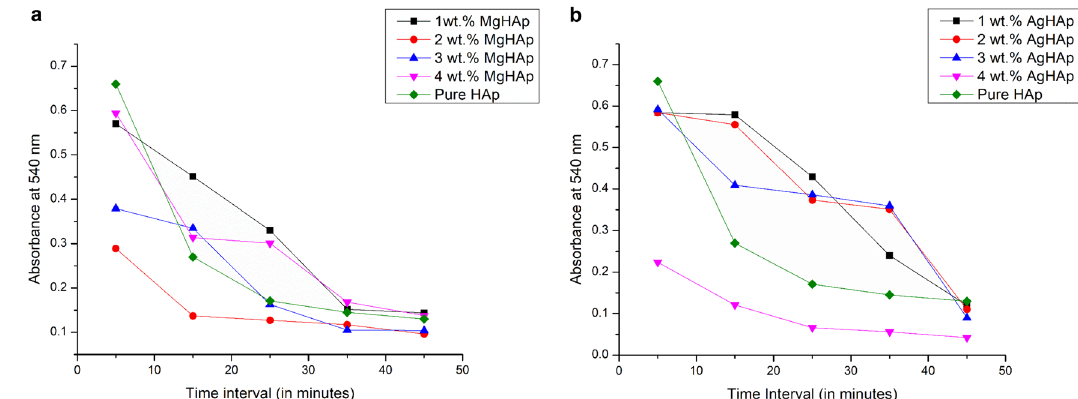
Fig. 8 a The thrombus behaviour of MgHAp samples. b The thrombus behaviour of AgHAp